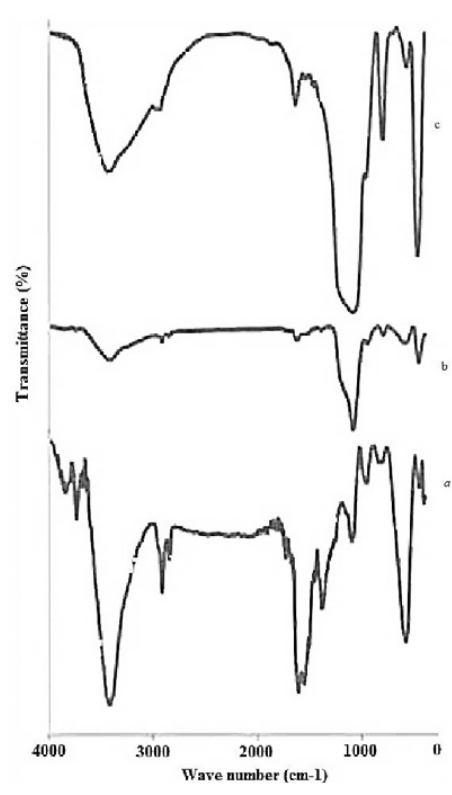
Fig. 7. The TEM image of ( a ) Fe